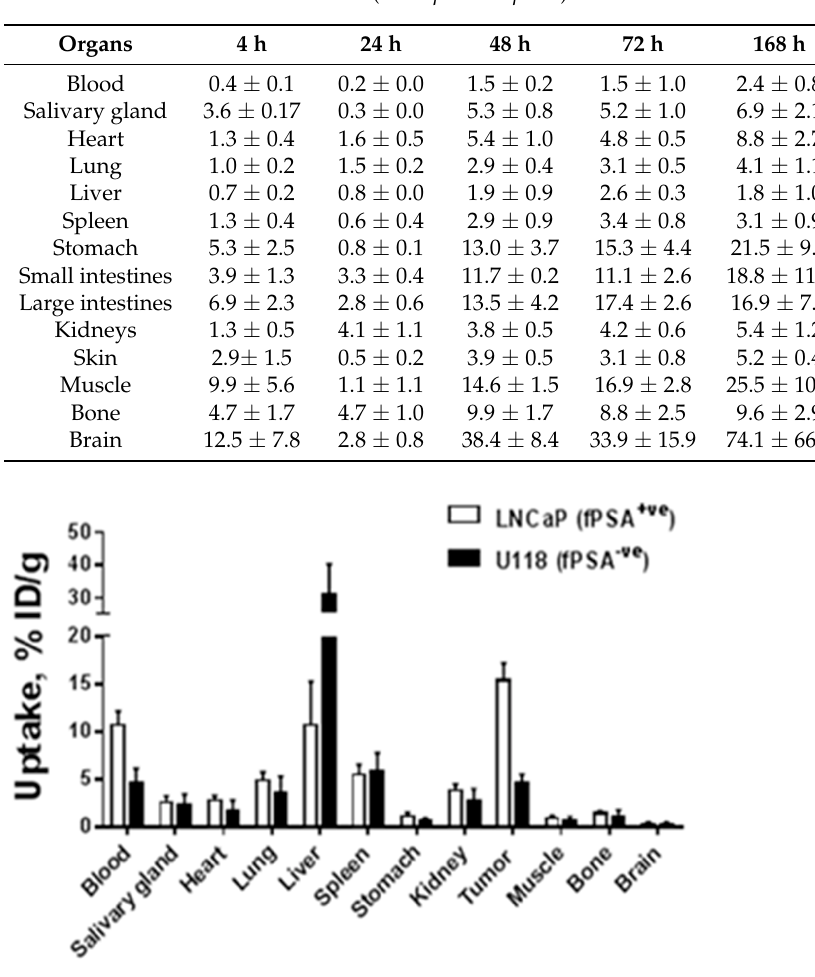
Figure 6. Comparative biodistribution of 177 Lu-h5A10 in NMRI mice bearing subcutaneous LNCaP (fPSA-expressing) and U118-glioblastoma (non-fPSA-secreting) xenografts 48 h p.i. The uptake is expressed as % injected dose per gram tissue (%ID/g), and presented as an average ± SD ( n = 4 ). Note the high specificity for 177 Lu-h5A10, p <